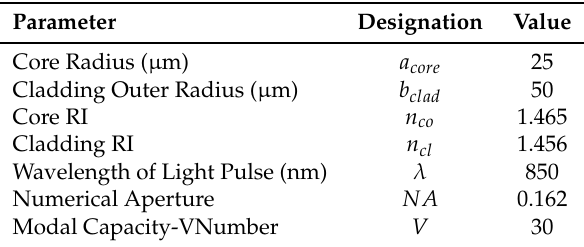
Table 1. Parameters characterizing the waveguide fiber used to verify solution methods. RI, Refractive